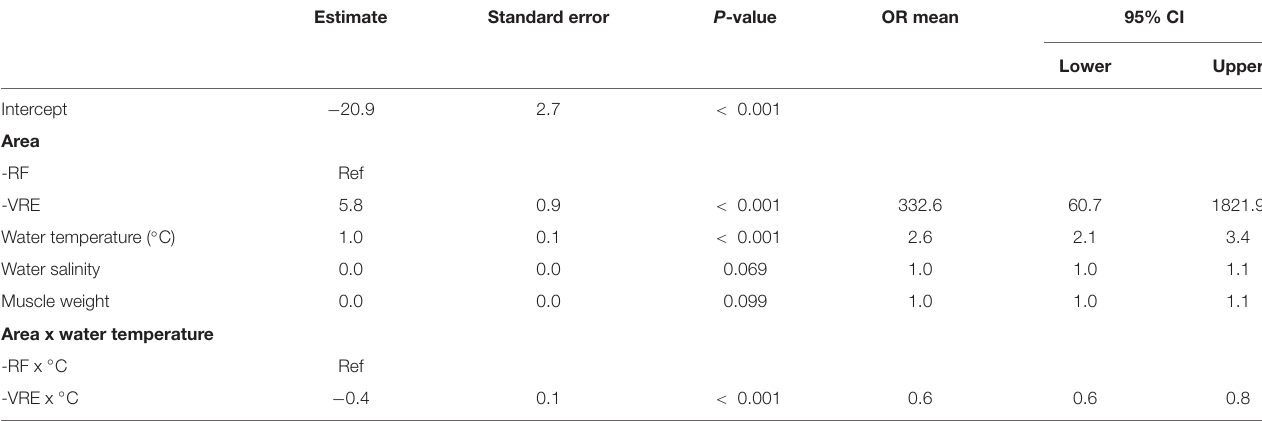
TABLE 5 | Generalized linear mixed effects model results of the association between the presence of total V. parahaemolyticus and predictive